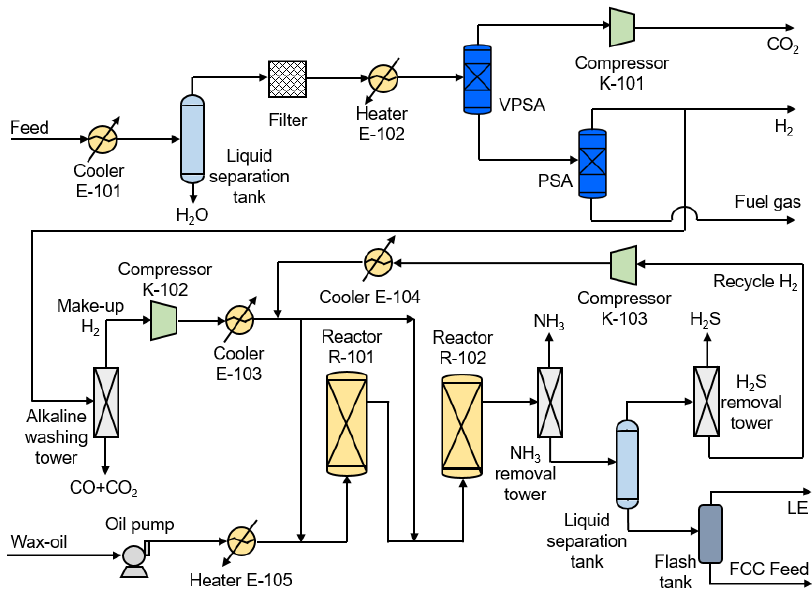
Figure 2. The schematic diagram of the CPGH (Conventional PSA Separation for H2/CO2 of Shifted Syngas and Gasoil Hydrogenation) Syngas and Gasoil Hydrogenation) process.